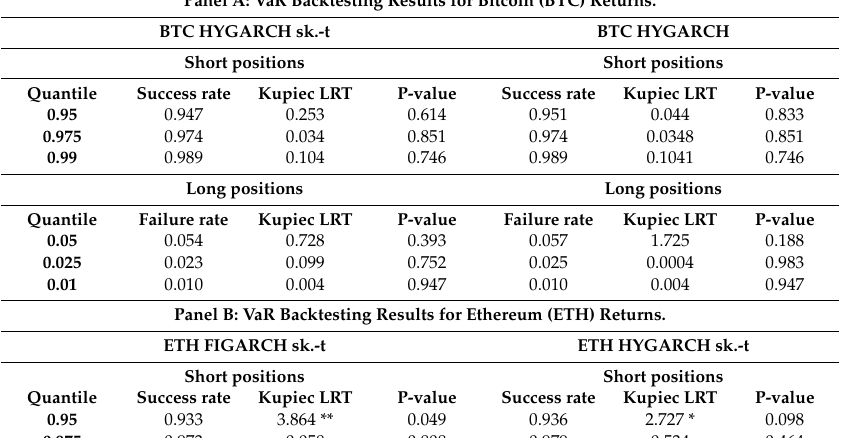
Panel C: VaR Backtesting Results for Ripple (XRP) Returns. XRP FIGARCH XRP FIGARCH sk.-t